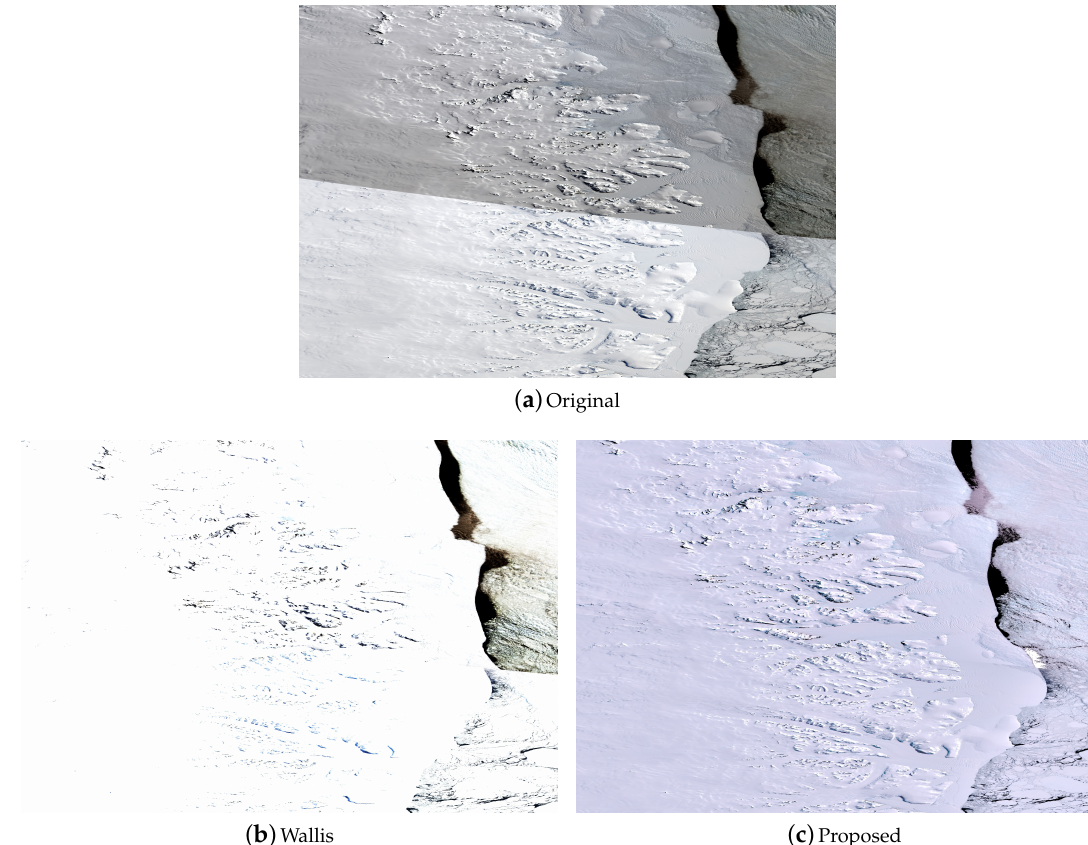
Figure 13. The details of the mosaic boundaries with ( a ) the original images, ( b ) the Wallis method, and ( c ) the proposed